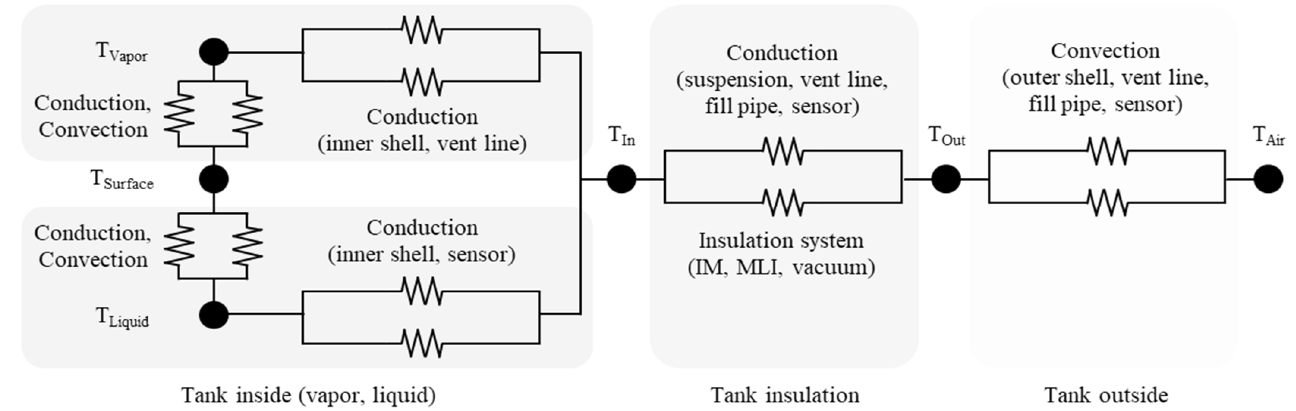
Figure 4. Thermal resistance diagram of a LH 2 insulation tank